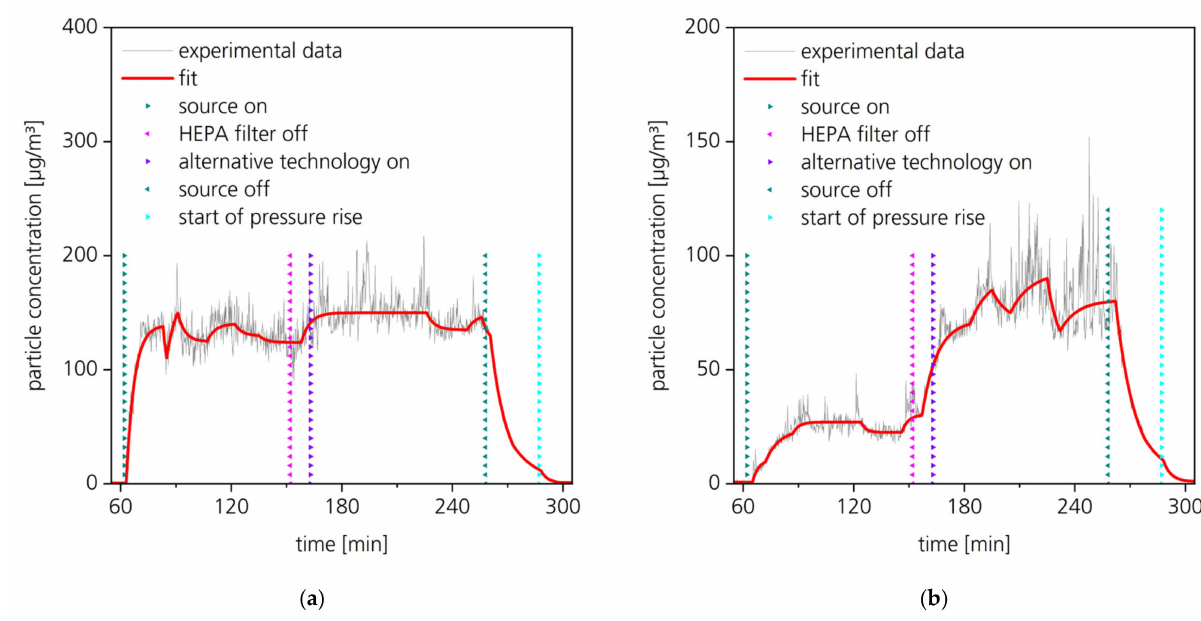
Figure 5. Experimental data of particle measurement (grey line) and fitted curve (red line) at positions in farther distance to the particle release: ( a ) PM 2.5 at position 2; ( b ) PM 2.5 at position 3.